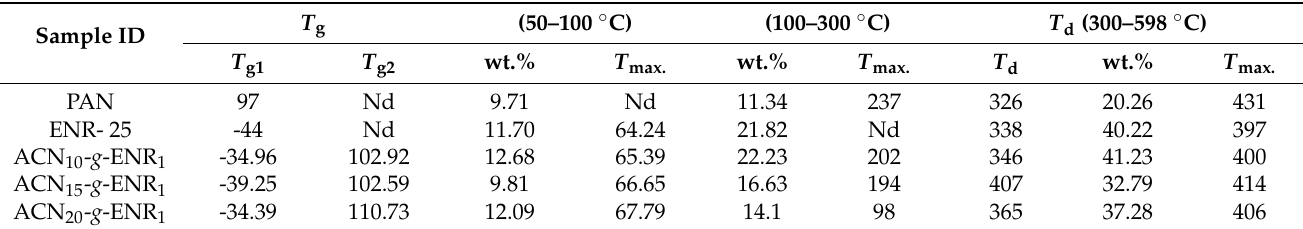
Figure 7. DSC thermograms of PAN, ENR- 25, and ACN- g -ENR products at different mole ratios. Table 4. Glass transition, T g and thermal degradation and maximum temperatures values from TGA and DTG curves of PAN, ENR- 25, and ACN- g -ENR products at different mole